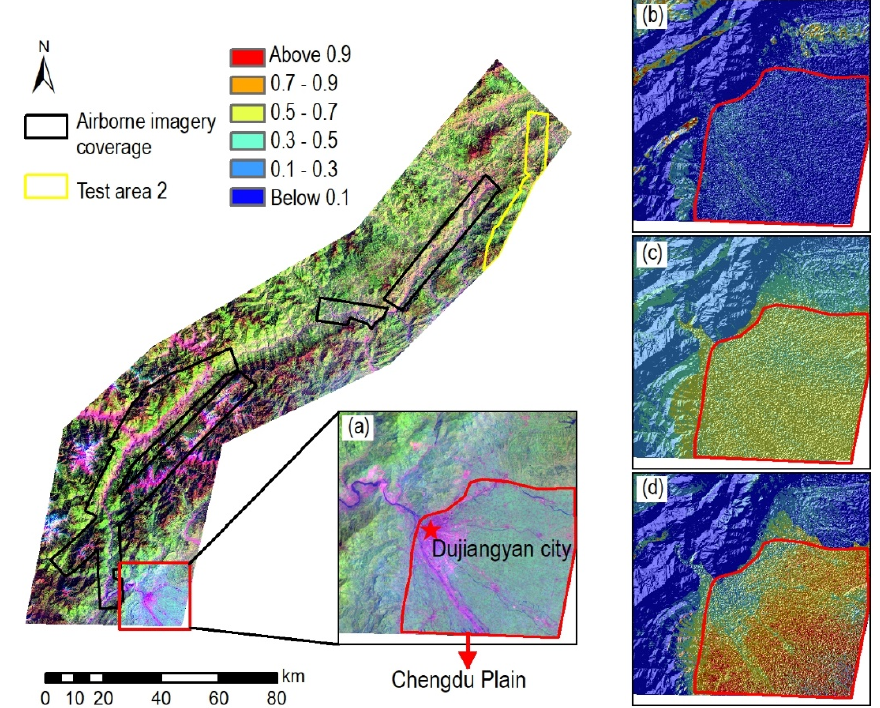
Figure 18. Comparing LSM results of three models on Chengdu Plain area. ( a ) TM 7/4/1 imagery of Chengdu Plain; ( b ) U ‐ net modeled LSM; ( c ) LR modeled LSM; and ( d ) SVM modeled LSM.